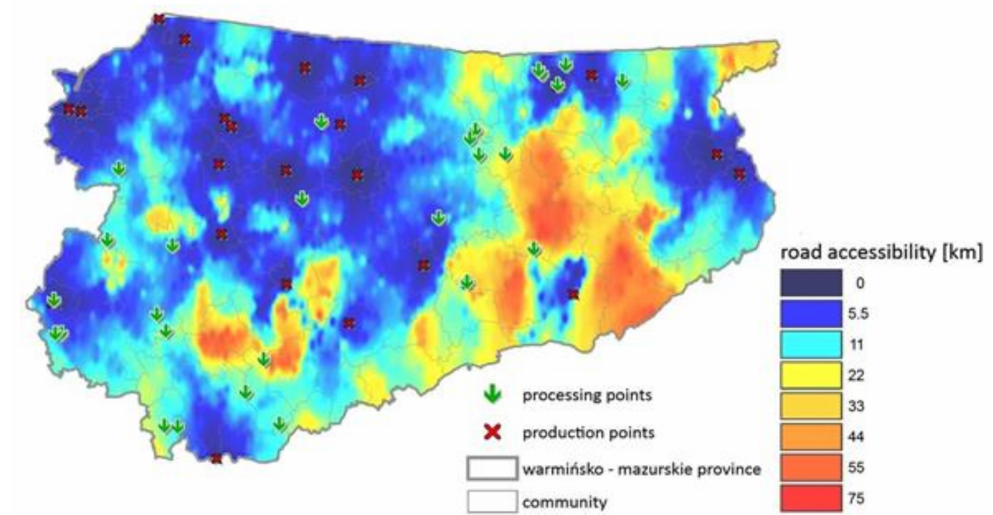
Figure 7. Travel time between biomass producers and biomass processing plants (warm colors denote longer travel time). Source: